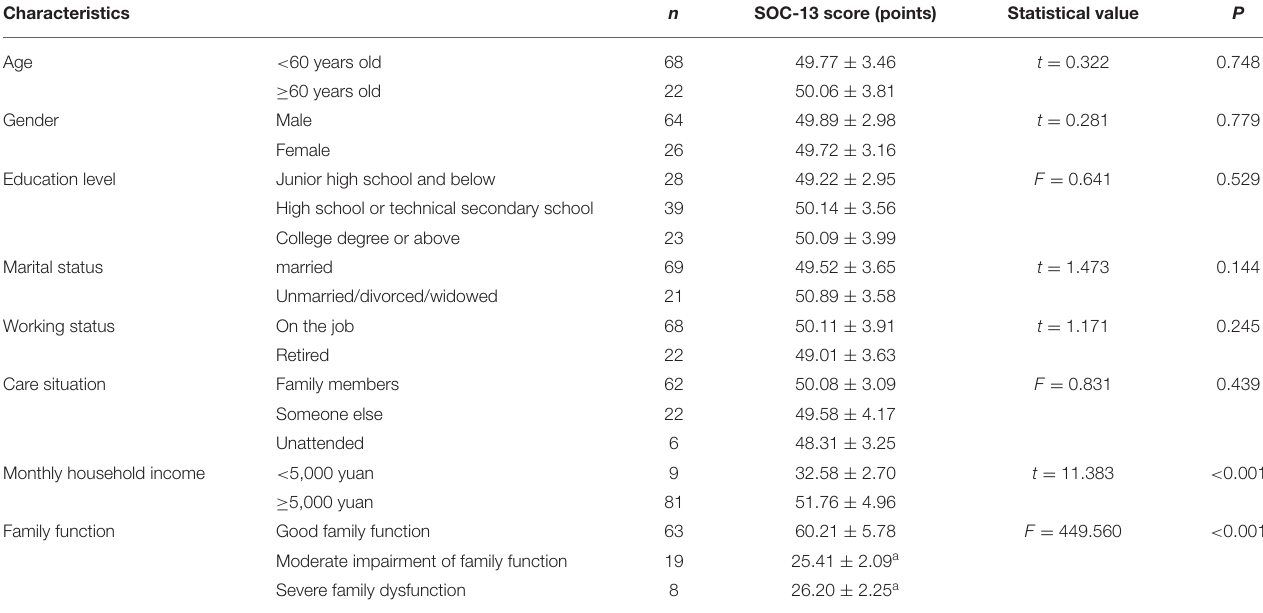
TABLE 3 | Comparison of the SOC-13 scores of patients with type A AD with different demographic characteristics.